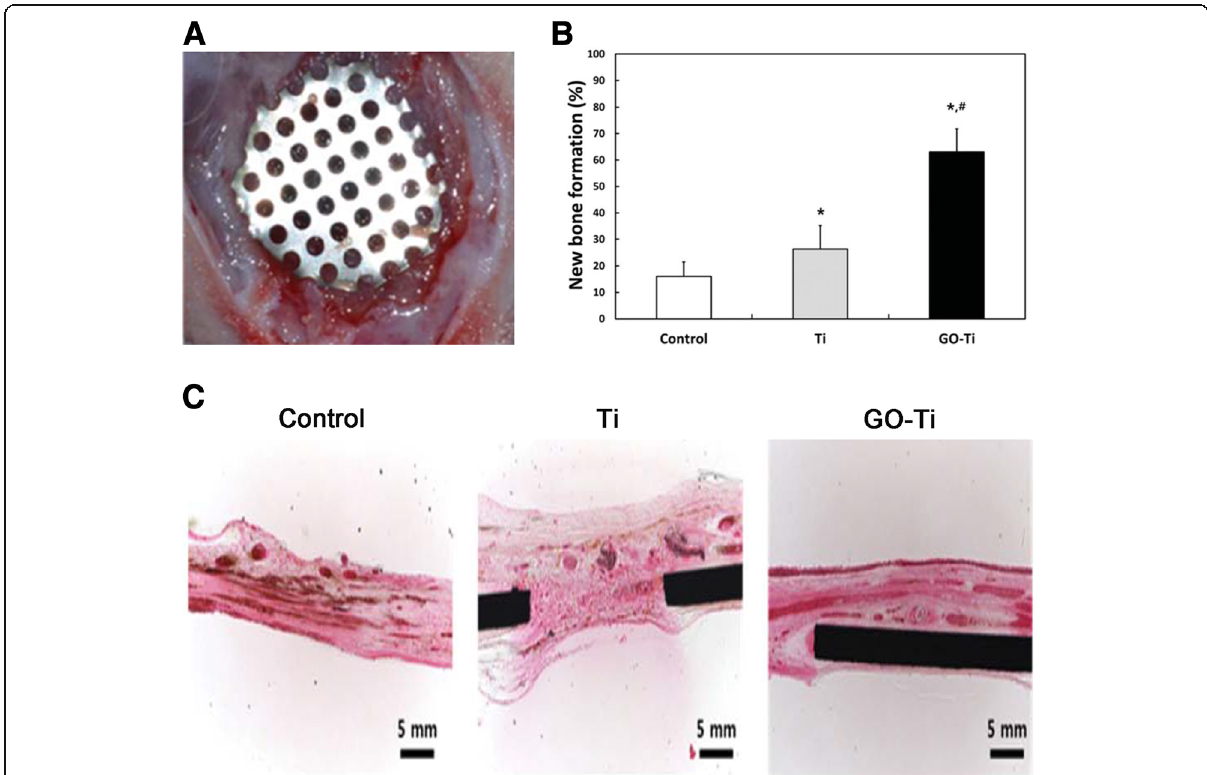
Fig. 6 a The calvarial defects of rats were enclosed with a GO-Ti membrane. b New bone formation of the rat calvarial defects after the implantation of Ti or GO-Ti membrane at postoperative week 8. * p <0.05 vs control; # p <0.05 vs Ti. c Images of HE staining of the rat calvarial defects after the implantation of Ti or GO-Ti membrane at postoperative week 8. Reproduced from ref. [128] with permission from the Journal of Applied Spectroscopy